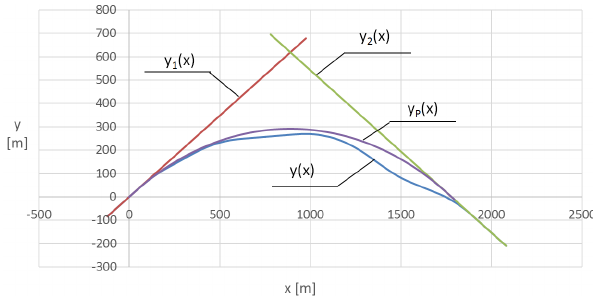
Figure 5: The existing and the designed geometric system in the local system of coordinates (variant I, using the non-isometric scales); y ( x ) – the existing course of the route, y 1 ( x ) and y 2 ( x ) – determined main directions of the route, y P ( x ) – designed course of the